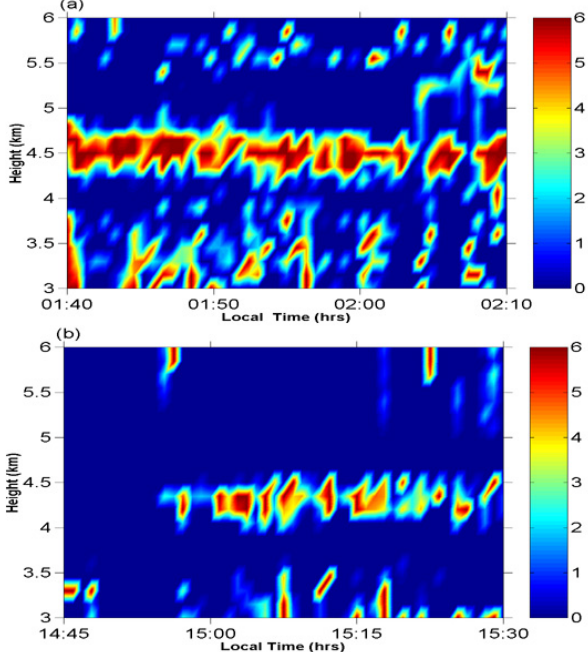
Fig. 11. Height-time sections of VHF radar signal-to-noise ratio (dB) revealing the radar bright band as observed on (a) 16 October 1997 and (b) 4 November